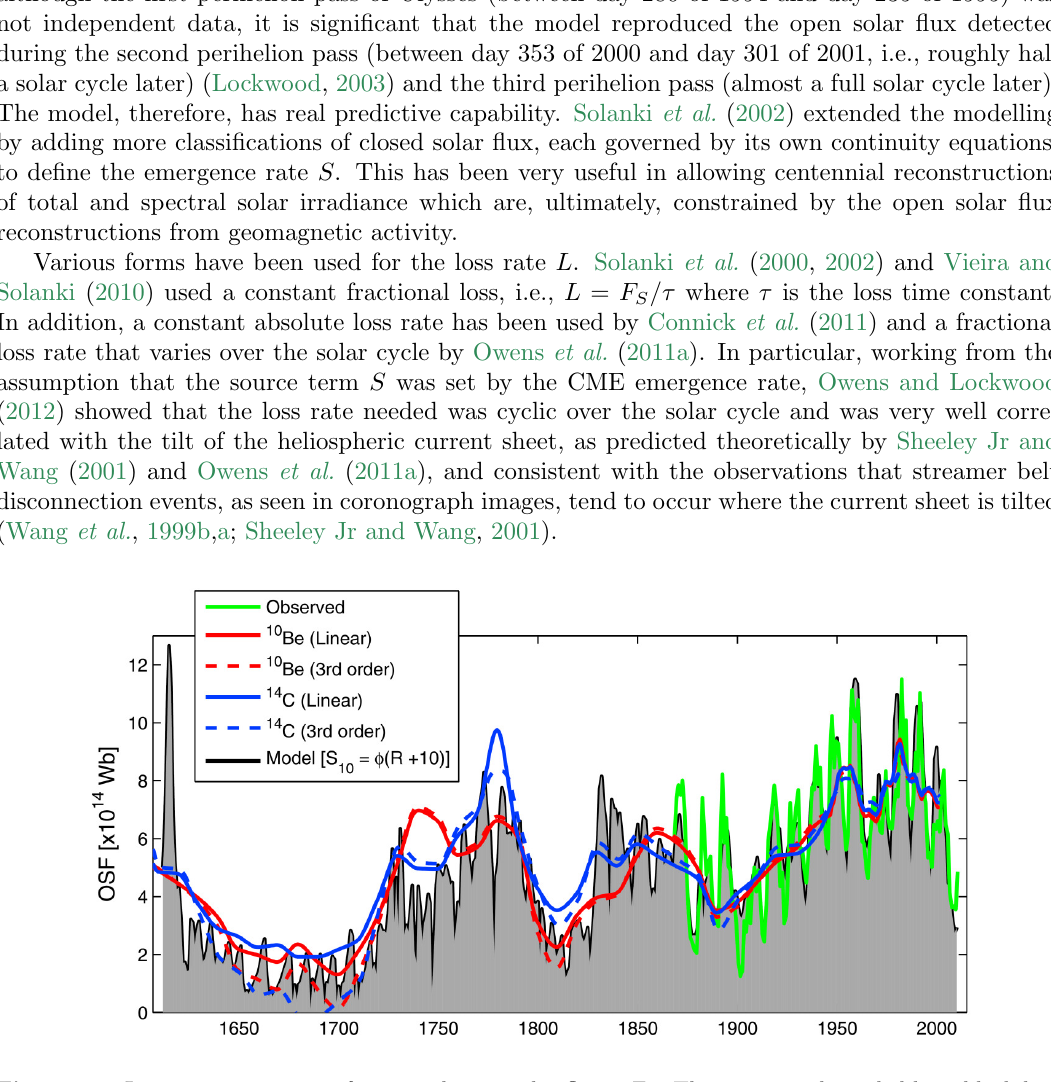
Figure 35: Long-term variation of unsigned open solar flux, 2 𝐹 𝑆 . The grey area bounded by a black line is a model fit to the green line which is the LEA09 reconstruction. Ten year averages of cosmogenic isotope estimates of open solar flux are shown in blue (from 14 C) and red (from 10 Be), with solid and dashed lines showing linear and third-order fits of the heliospheric modulation potential variation to the open solar flux reconstruction from geomagnetic activity. Image reproduced by permission from Owens and Lockwood (2012), copyright by